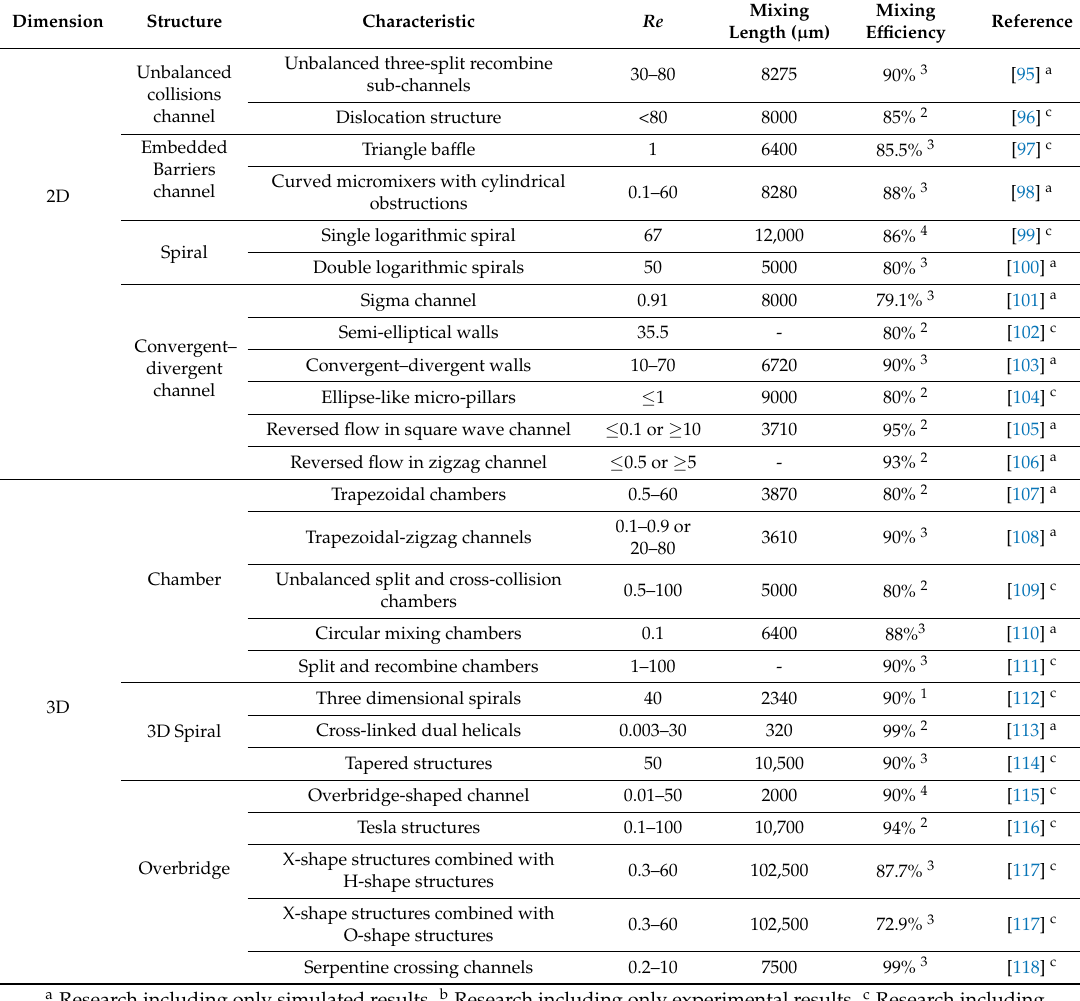
Table 2. Active micromixers reported in recent five